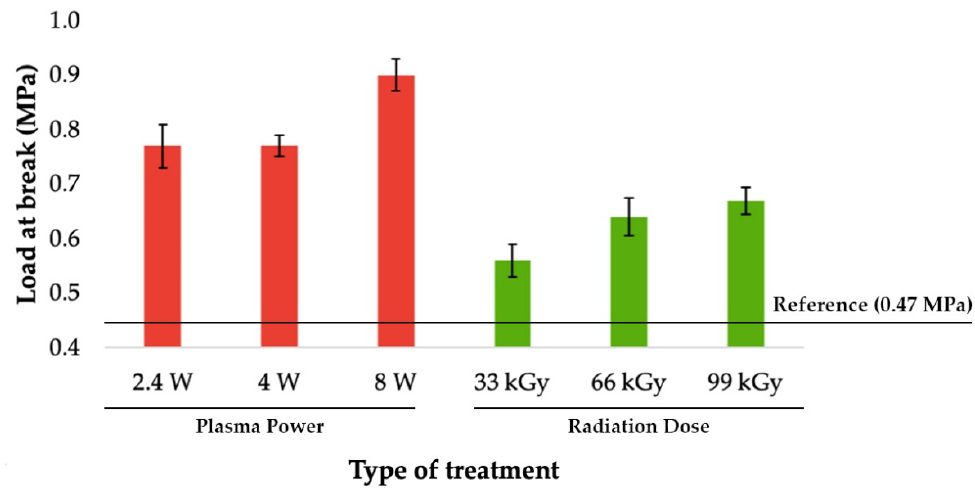
Figure 7. Load-bearing of adhered joints for two-component acrylate adhesive (depending on plasma power and radiation dose).